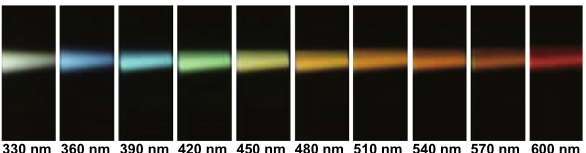
Fig. 5 PL emission of CDs excited from 330 to 600 nm in 30 nm increments [73]. Copyright (cid:2) 2015 WILEY–VCH Verlag GmbH & Co. KGaA,